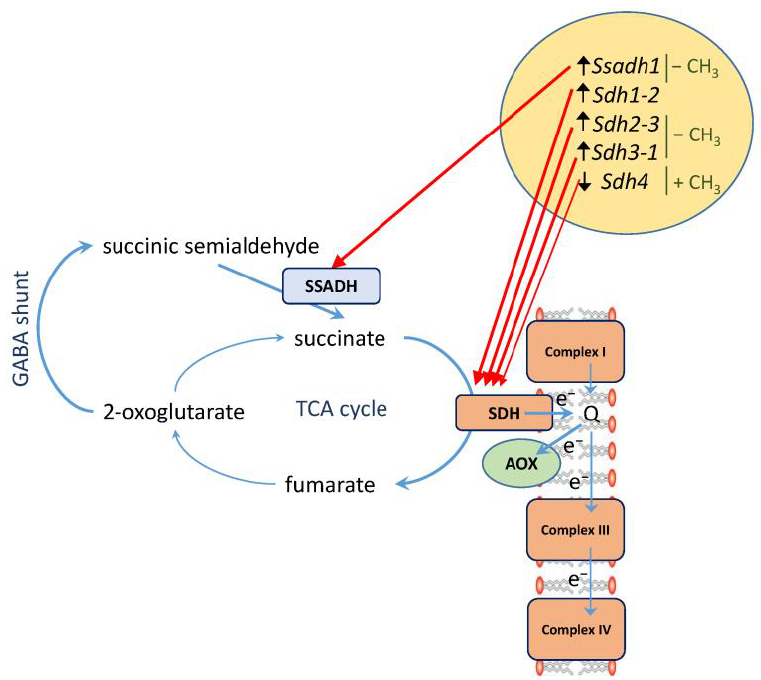
Figure 4. Scheme of succinate metabolism in maize leaves under salt stress. In the conditions of salt stress, the TCA cycle is bypassed via the GABA shunt. Succinic semialdehyde dehydrogenase (SSADH) supplies succinate to succinate dehydrogenase (SDH) which three subunits are induced at the level of transcription of the corresponding genes, while the expression of the fourth subunit is suppressed. The changes in expression are controlled by methylation of promoters of the corre- sponding genes ( − CH 3 , decrease in methylation level; + CH 3 , increase in methylation level). The flow of electrons via alternative oxidase (AOX) is increased. Thick arrows indicate the processes that are activated, thin arrows show the processes that do not change or are suppressed.